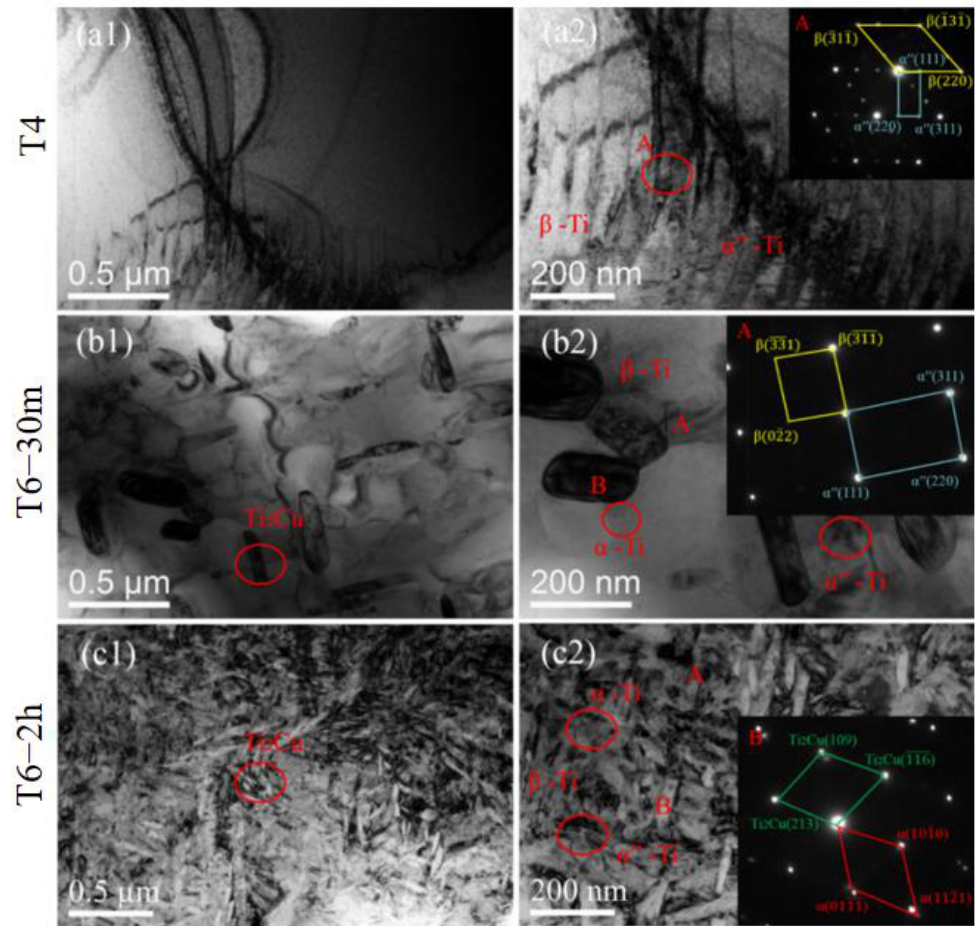
Figure 6. TEM images of TNZ-7Cu samples. ( a1,a2 ) TNZ-7Cu(T4); ( b1,b2 ) TNZ-7Cu(T6-30m); ( c1,c2 ) TNZ-7Cu (T6-2h). Table 1. Phase constitution of TNZ-xCu at different conditions.